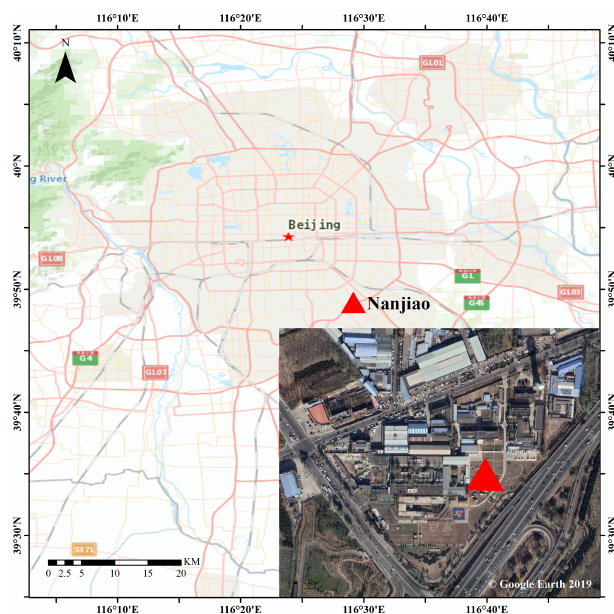
Figure 1. The map of the area surrounding the sampling site (Nan- jiao) and true color image of the observation station. This map was made by ArcGIS (http://www.arcgis.com/index.html#, last access: 17 February 2022). The true color image of the observation station is from © Google Earth